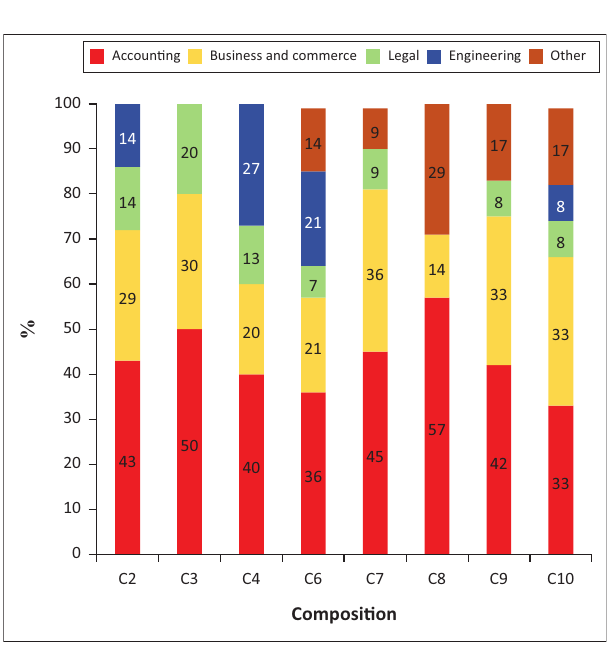
FIGURE 3: Board composition of participating companies.